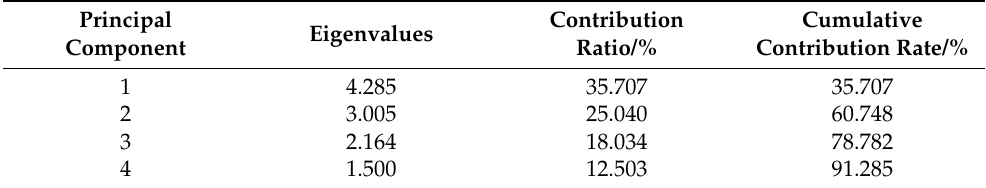
Table 7. The eigenvalues, contribution ratio, and cumulative contribution ratio of the principal components under moderate drought stress.